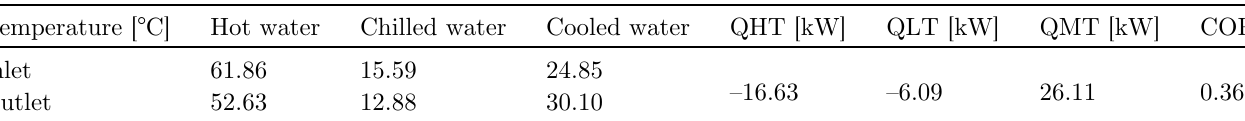
Table 3. Temperature average and speci fi c heat capacity at 60 ° C/15 ° C/25 ° C. Temperature [ °